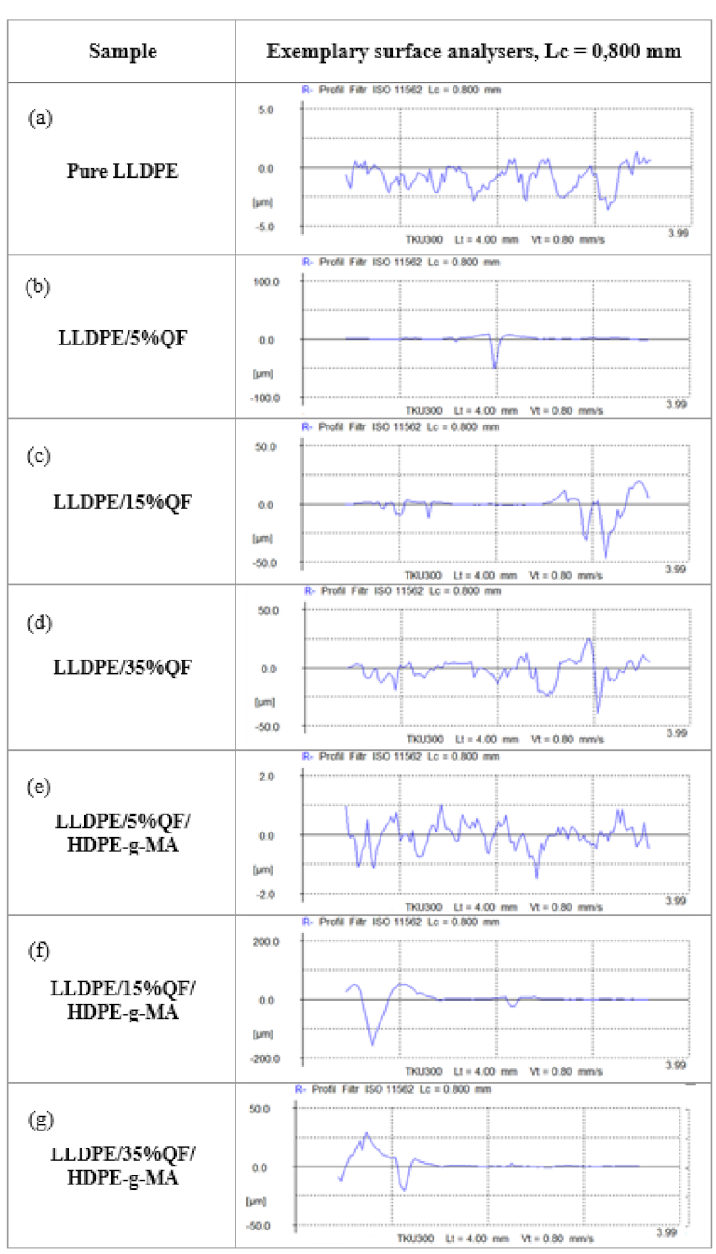
Figure 16. Profilograms of linear low-density polyethylene and composite samples: ( a ) pure LLDPE, ( b ) LLDPE/5%QF, ( c ) LLDPE/15%QF, ( d ) LLDPE/35%QF, ( e ) LLDPE/5%QF/HDPE-g-MA, ( f )